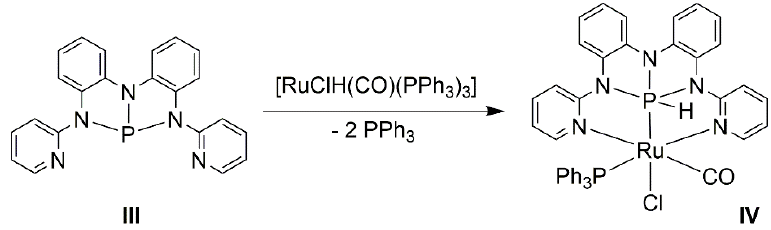
Table A1. Crystallographic data from data collection and refinement processes for 3a , 4a